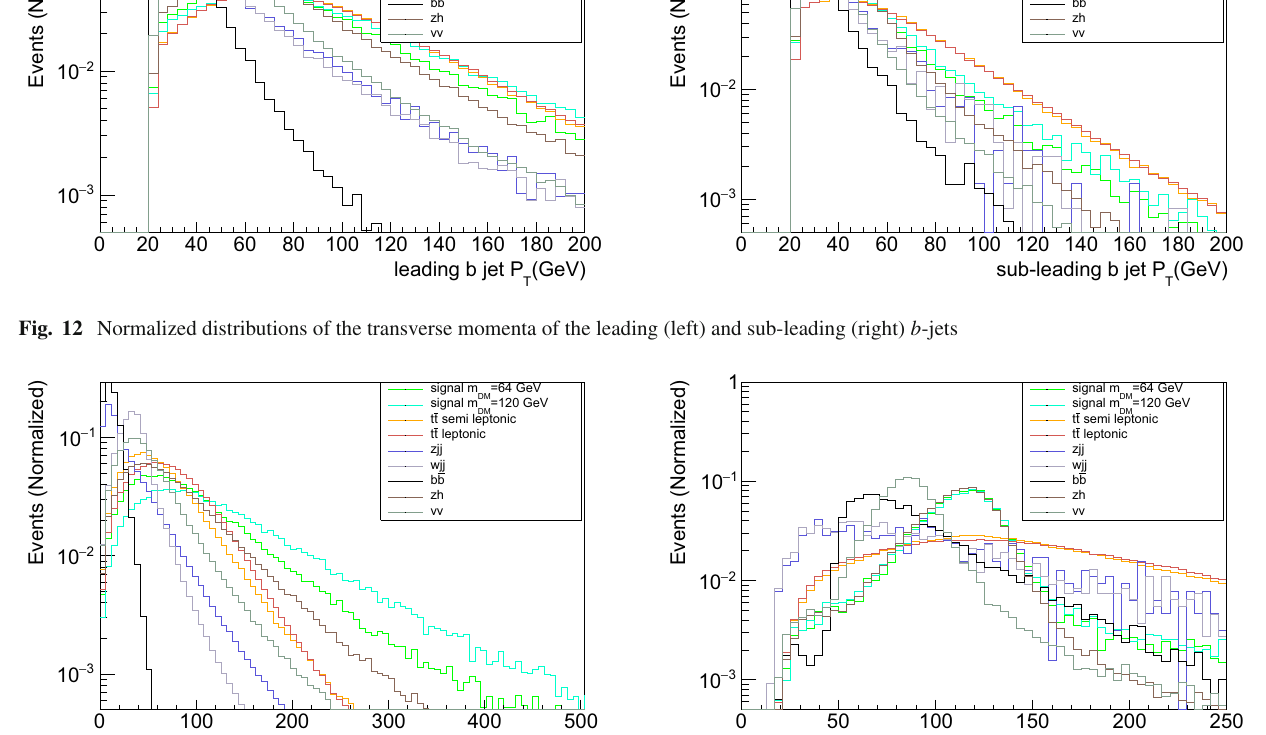
clear from the cut-flow analysis in the next subsection. The / E T peaks at much lower values in case of V +jets as well.